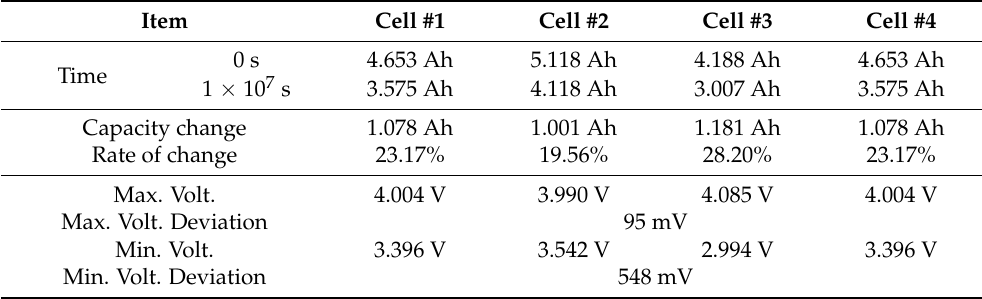
Table 4. Aging progress results of series-connected batteries with ± 10% capacity deviation. Item Cell #1 Cell #2 Cell #3